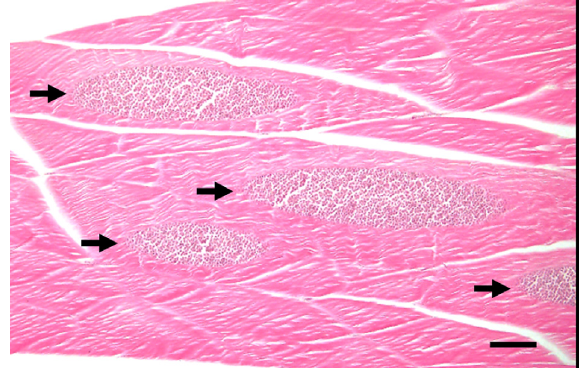
Figure 1. Stained histological section of olive flounder ( Paralich- thys olivaceus ) muscle showing the muscle fibres substituted with Kudoa spores. Arrows indicate infection with K. septempunctata spores. Haematoxylin and eosin staining. Scale bar = 100 l m.